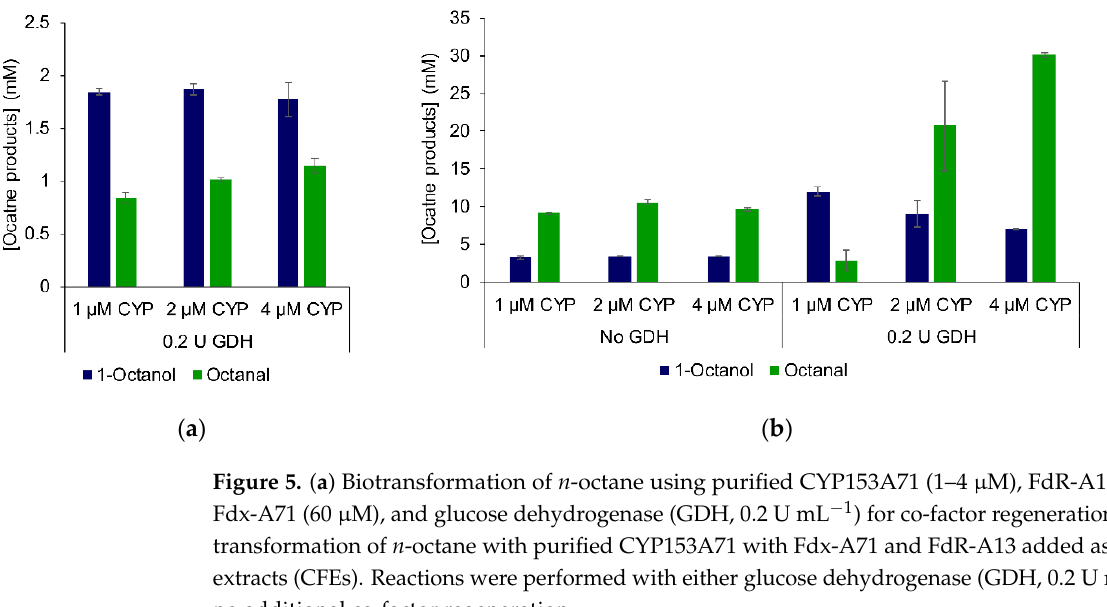
Figure 5. ( a ) Biotransformation of n -octane using purified CYP153A71 (1–4 µM), FdR-A13 (1 µM), Fdx-A71 (60 µM), and glucose dehydrogenase (GDH, 0.2 U mL − 1 ) for co-factor regeneration; ( b ) biotransformation of n -octane with purified CYP153A71 with Fdx-A71 and FdR-A13 added as cell-free extracts (CFEs). Reactions were performed with either glucose dehydrogenase (GDH, 0.2 U mL − 1 ) or no additional co-factor regeneration.